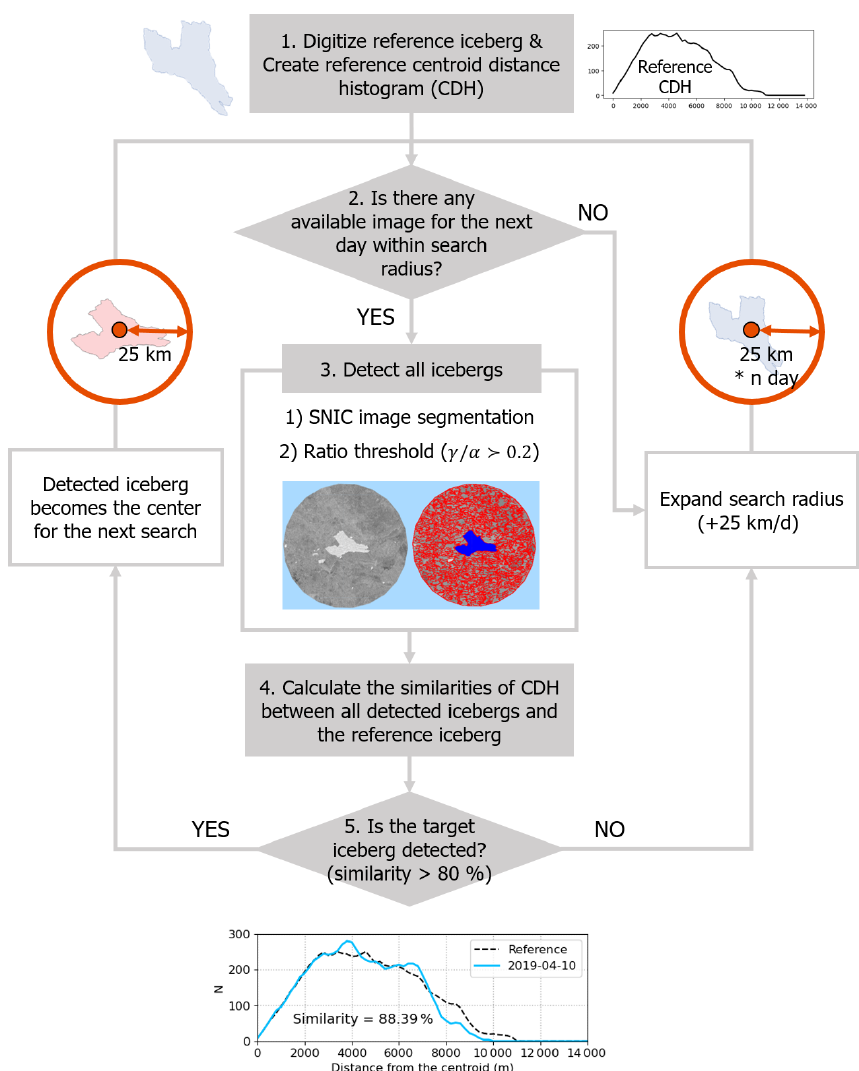
Figure 3. Flowchart illustrating the steps of the semi-automated procedure for iceberg detection and tracking. Details are provided in the text (Sect.